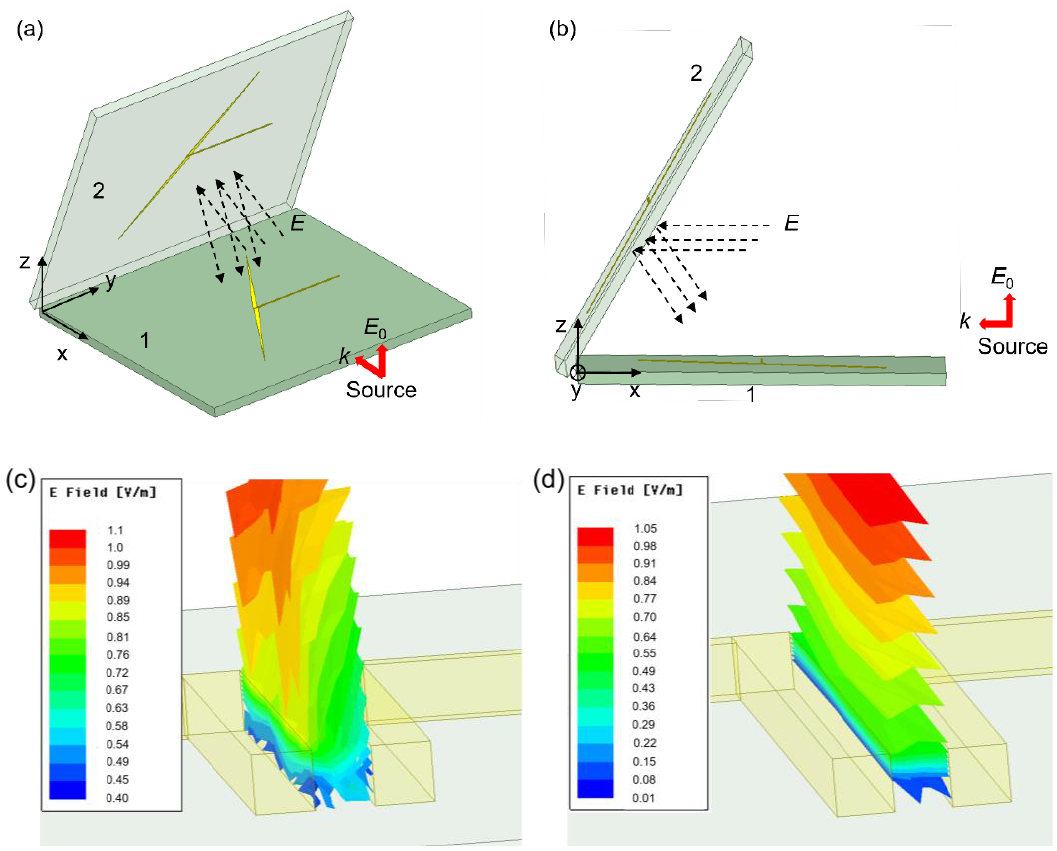
Figure 4. ( a ) Perspective view and ( b ) lateral view of the simulation mode of the two-chip mode; ( c ) simulation results of the induced electric field of the two-chip mode and ( d ) the one-chip mode.